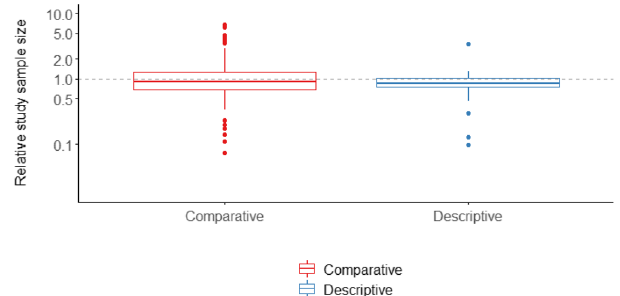
Fig. 1 | Relative magnitude of sample size (original/reproduction). Study sizes summed across compared exposure groups for both the original and replication cohorts. Y-axisticks onlog scale, axis labelsre fl ectactualvalue. Dashed horizontal gray line at 1.0 re fl ects equal sample size in original and reproduction cohorts. Boxplot elements: center line, median; box limits, upper and lower quartiles; whiskers, 1.5x interquartile range; points, outliers. N =118 comparative, N =32 descriptive studies. Source data are provided as a Source Data fi